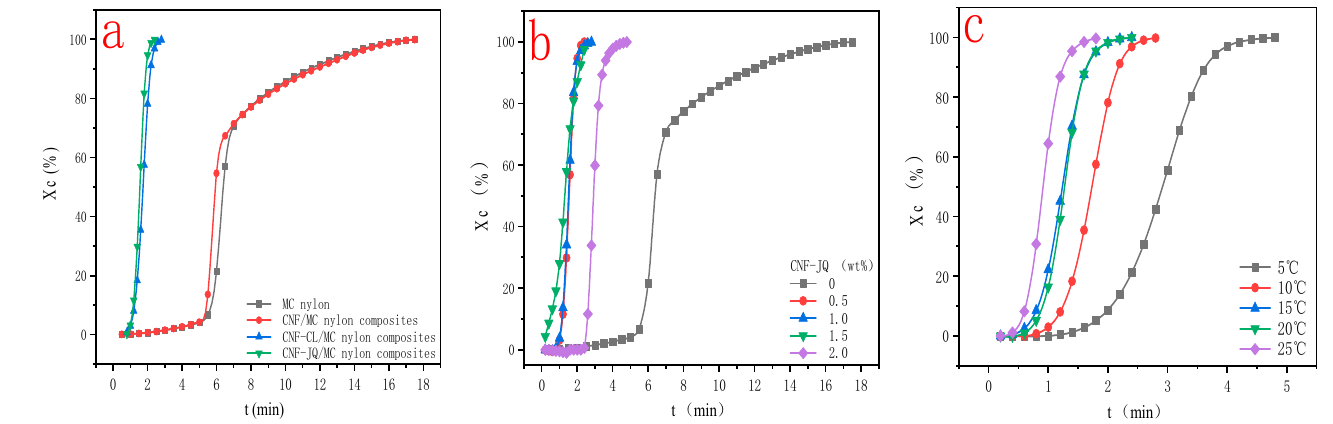
Figure 12. Curves of time versus crystallinity for MC nylon and its composites (( a ) for different modified CNF at a cooling rate of 10 °C; ( b ) for different CNF–JQ additions at a cooling rate of 10 °C; ( c ) for different cooling rates at 1.0 wt% CNF–JQ).